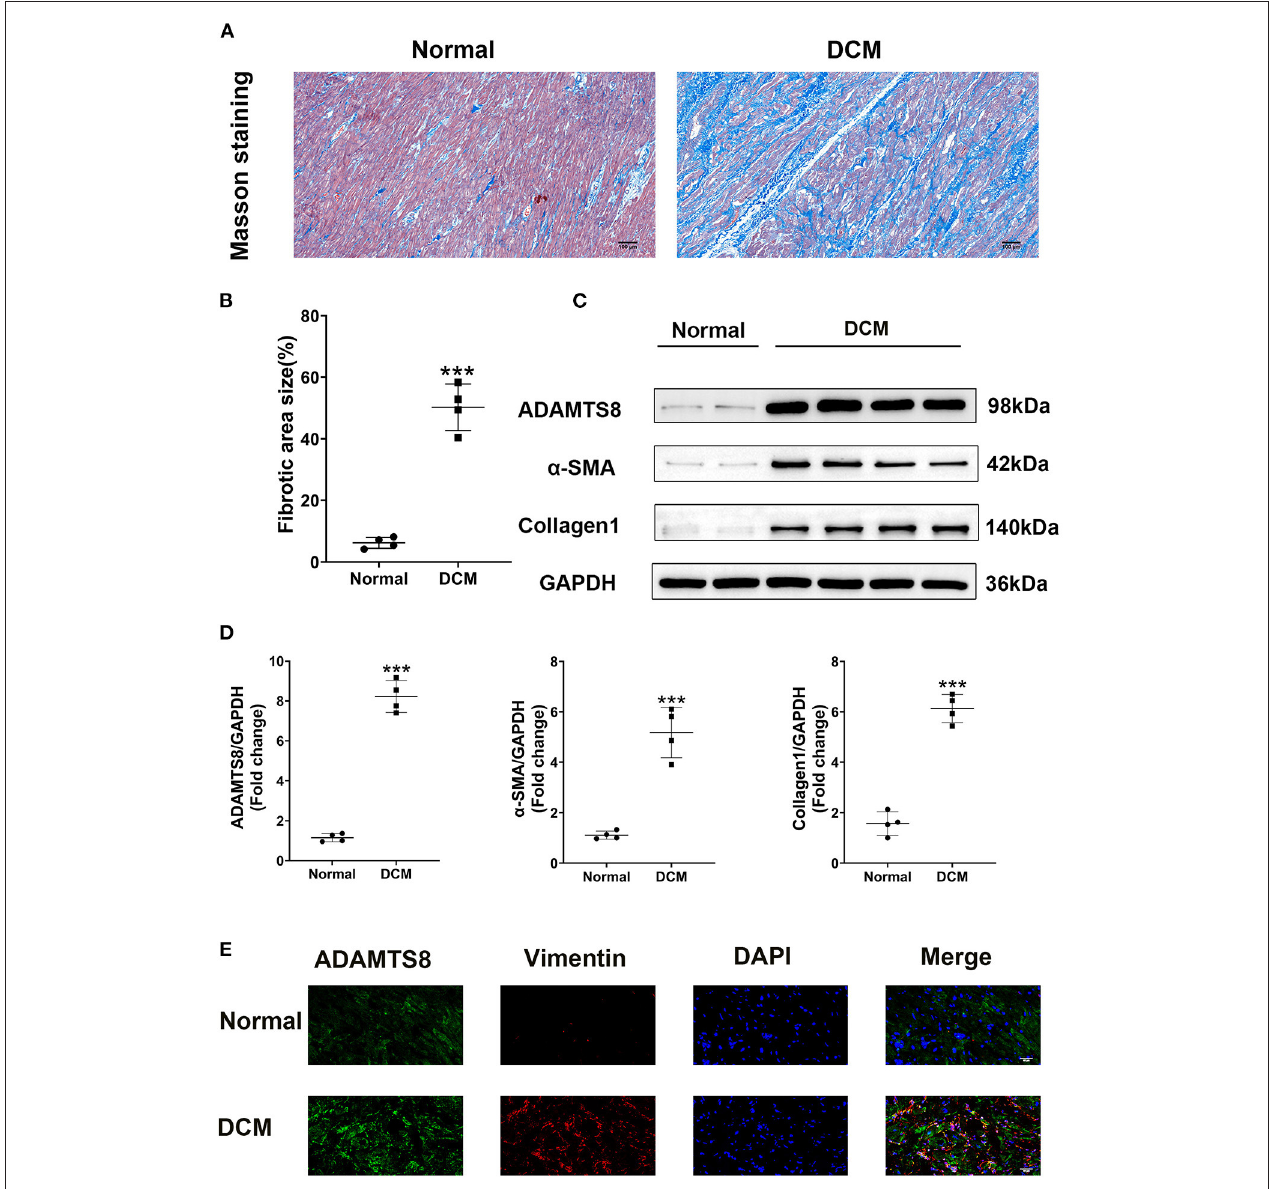
FIGURE 1 | ADAMTS8 expression was increased in DCM patients with severe cardiac fibrosis. (A,B) Representative Masson staining (scale bar = 100 µ m) and quantification of fibrosis. (C,D) Representative western blotting and quantification of ADAMTS8, α -SMA, and Collagen1 expression in the ventricular septum from hearts obtained from patients with DCM and normal hearts. (E) Immunofluorescence staining of ADAMTS8 and Vimentin in the ventricular septum from hearts from patients with DCM and normal hearts (scale bar = 40 µ m). Data were presented as mean ± SEM. *** P < 0.001 vs. Normal group.